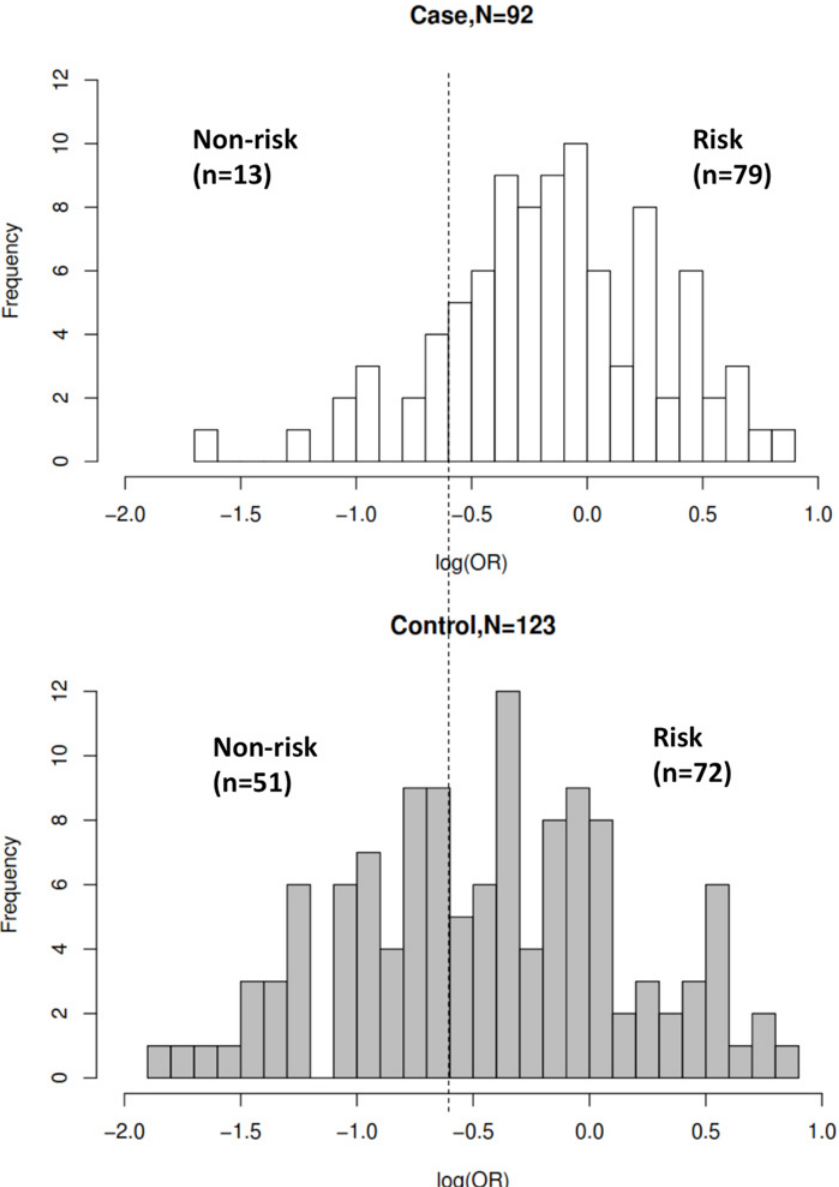
Fig 2. Histogram plot with case-control frequency versus distribution of log (OR). Threshold of the plot was obtained from AUC curve with optimal sensitivity and specificity. Significant difference ( P = 1.12x10 -5 ) was observed between risk and non-risk of case-control in this study with odds ratio of 4.30 (95%CI = 2.07 –